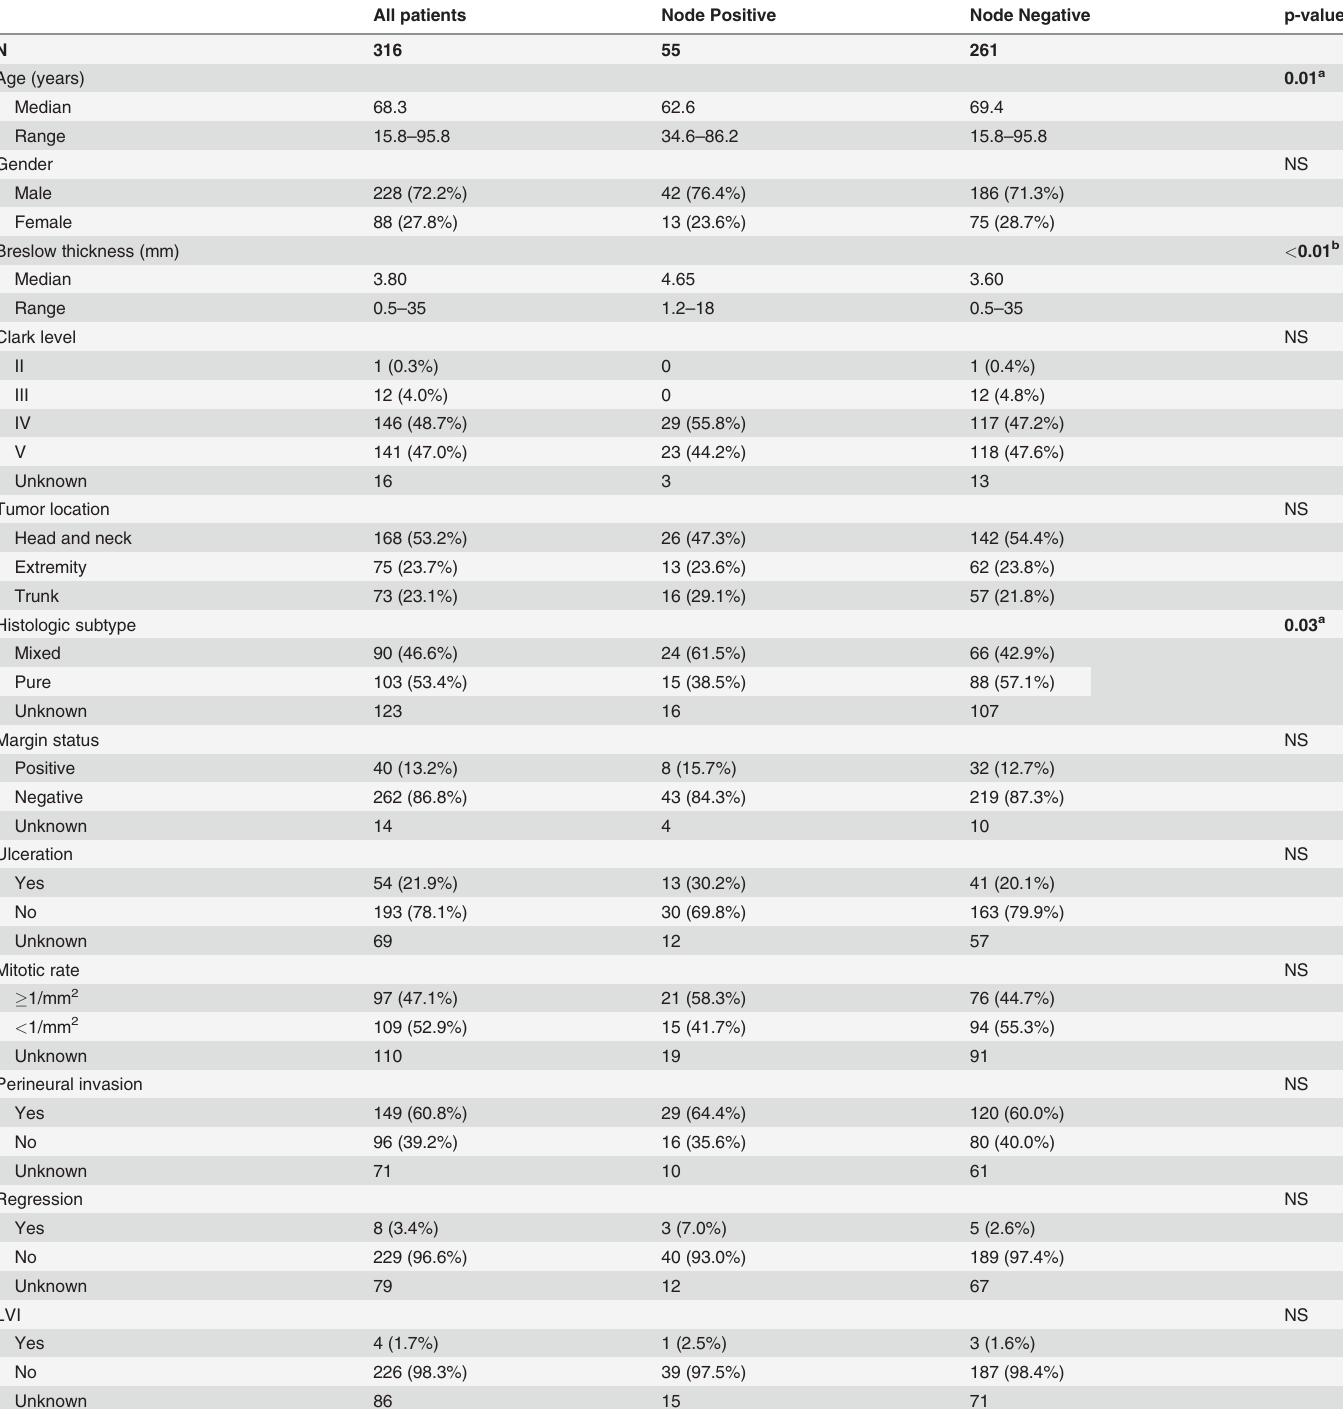
Table 1. Clinicopathologic characteristics correlated with nodal status in patients with clinically localized desmoplastic melanoma. All patients Node Positive Node